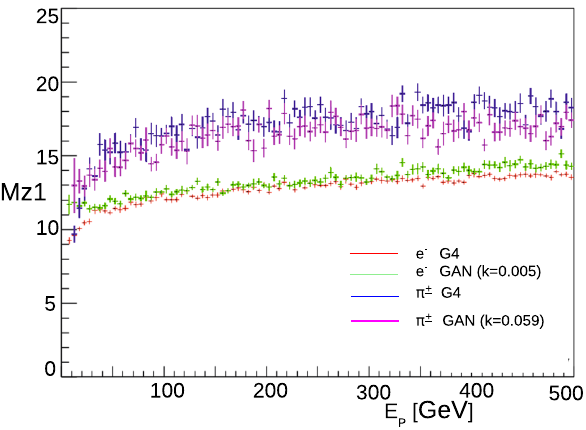
Fig. 18 The distribution for the first moment along the Z axis (Mz1) for electrons and charged pions. The barycenter of deposition along the Z axis shows very different distributions for both particles with the charged pion showers starting much later. The p-value from Kol- mogorov test is represented as k